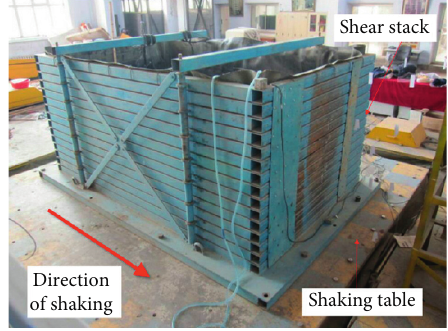
Figure 2: The shear stack installed on the shaking table.